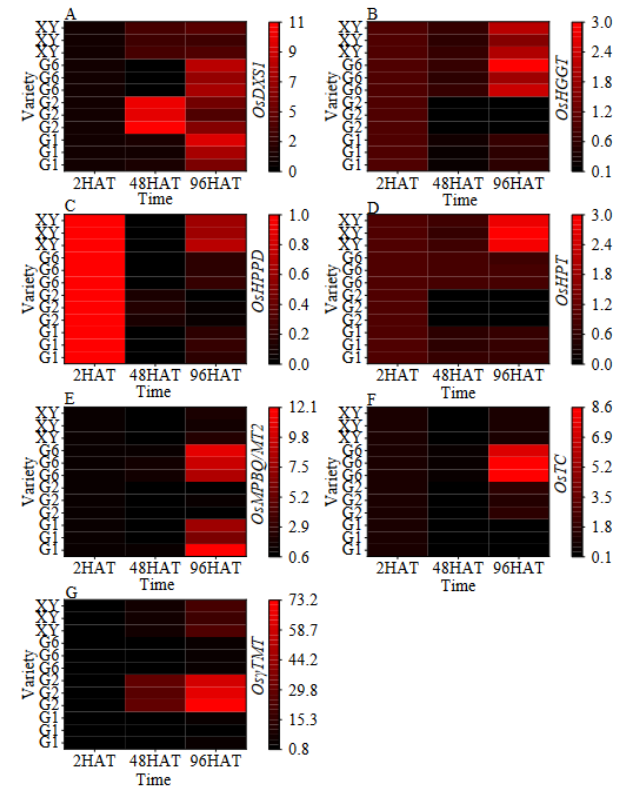
Figure 5. Heat map of the dynamic changes in vitamin E synthetic gene expression during germination of brown rice. ( A ): The OsDXS1 gene expression. ( B ): The OsHGGT gene expression. ( C ): The OsHPPD gene expression. ( D ): The OsHPT gene expression. ( E ): The OsMPBQ/MT2 gene expression. (F): The OsTC gene expression. ( G ): The Os γ -TMT gene expression. Treatments: 2 h after seed soaking treatment (2HAT), 48 h after seed soaking treatment (48HAT), 96 h after seed soaking treatment (96HAT). Varieties: Guanghei1 (G1), Guichao2 (G2), Guanghong6 (G6), Xiangyaxiangzhan (XY).